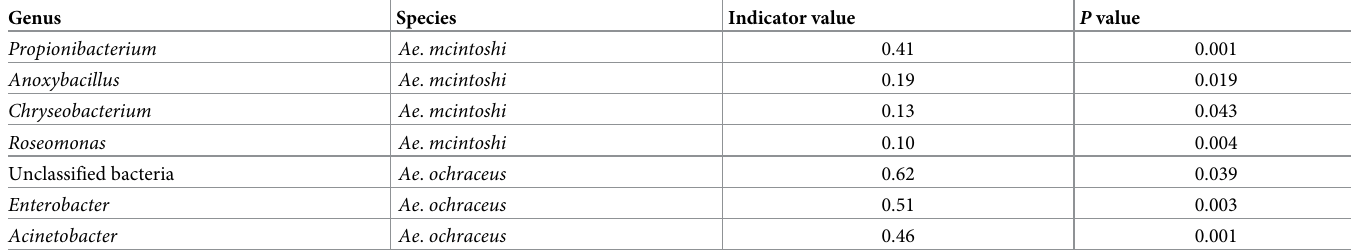
Table 3. Results of indicator species analysis showing the microbial genera that were significantly associated with the two vectors of RVF virus.